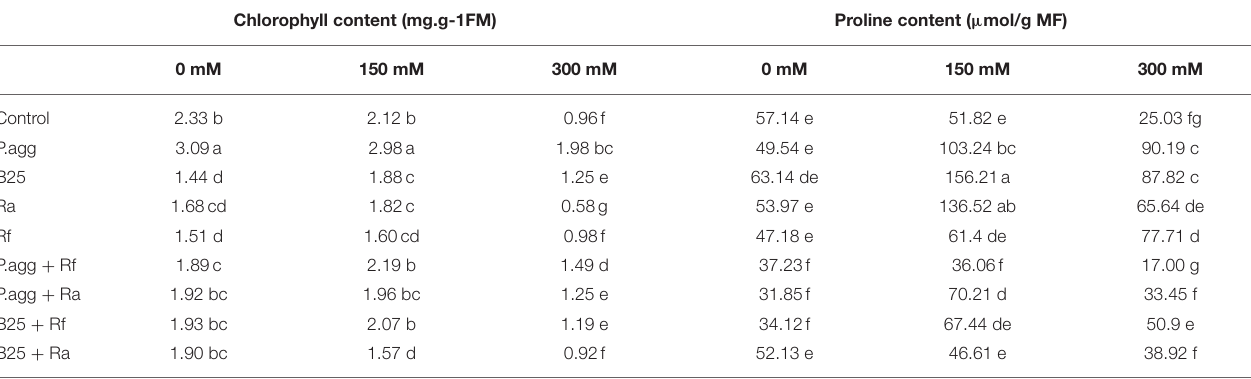
TABLE 3 | Total chlorophyll and proline content of C. obesa plants inoculated with PGPR and/or AMF subject to 0, 150, and 300mM NaCl. Chlorophyll content